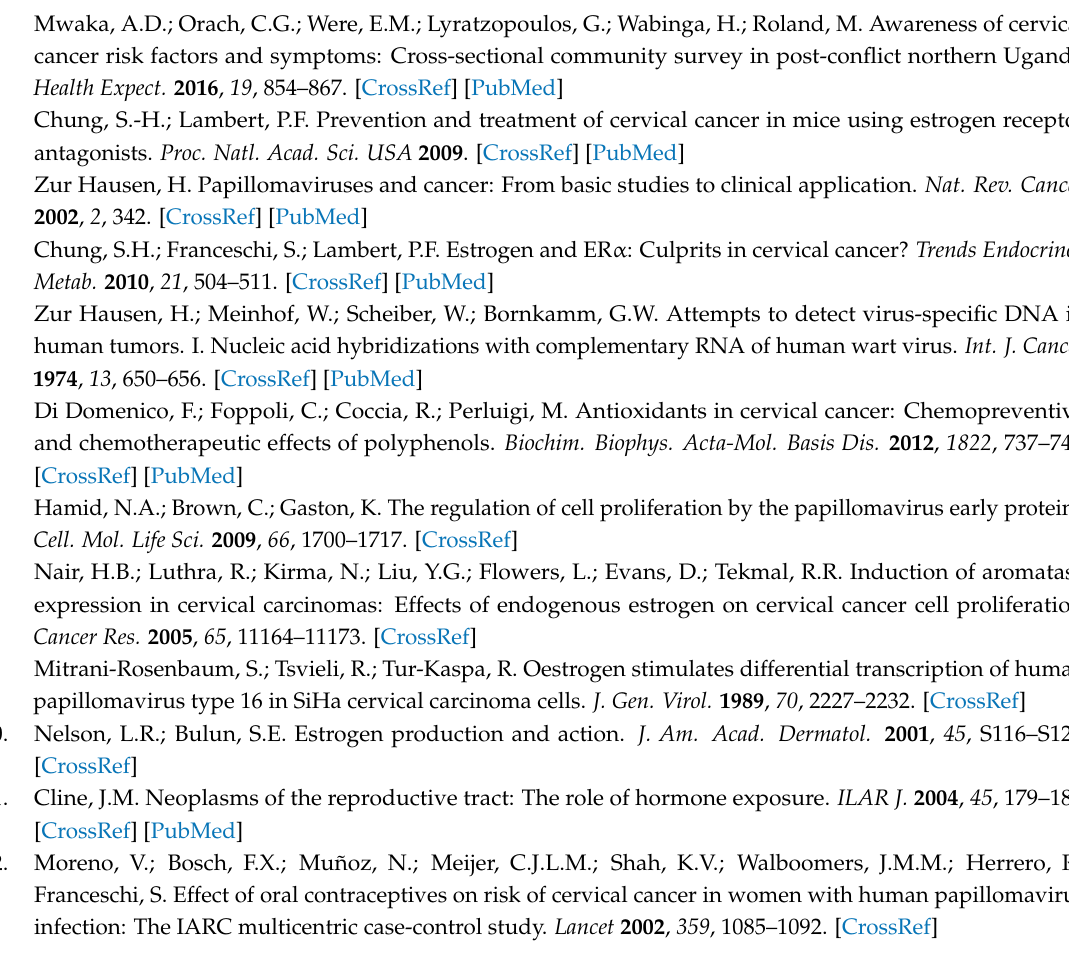
Figure S1: Molecular dynamics simulations results, Figure S2: Accommodation of the ligand at the active site of the protein and is observed to be seated at the substrate binding site, Figure S3: The identified compound demonstrates the pharmacophore features of both the models, Figure S4: Blots 1, 2, and 3 were done in parallel with three different SDS-PAGE gels by using same cell lysates. Blots were cropped depending upon molecular size of protein of study. In Blot-3, A was probed with Bcl2 (SC-7380) to see its expression then the blot was treated with harsh stripping process and re-probed with SC-7480 for Bax analysis in blot B; Table S1: 2D structures and molecular dock scores of top nine